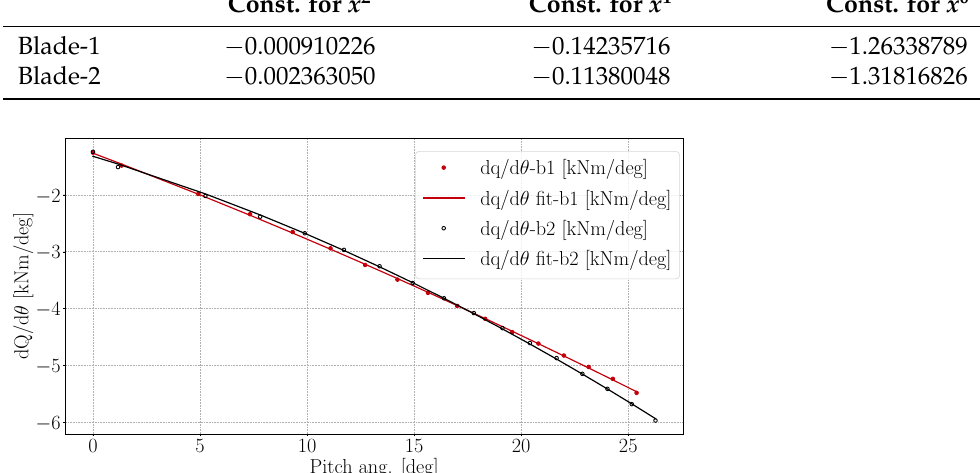
Table 3. Second order polynomial fit constants for aerodynamic gains computed in HAWCStab2. Const. for x 2 Const. for x 1 Const. for x 0